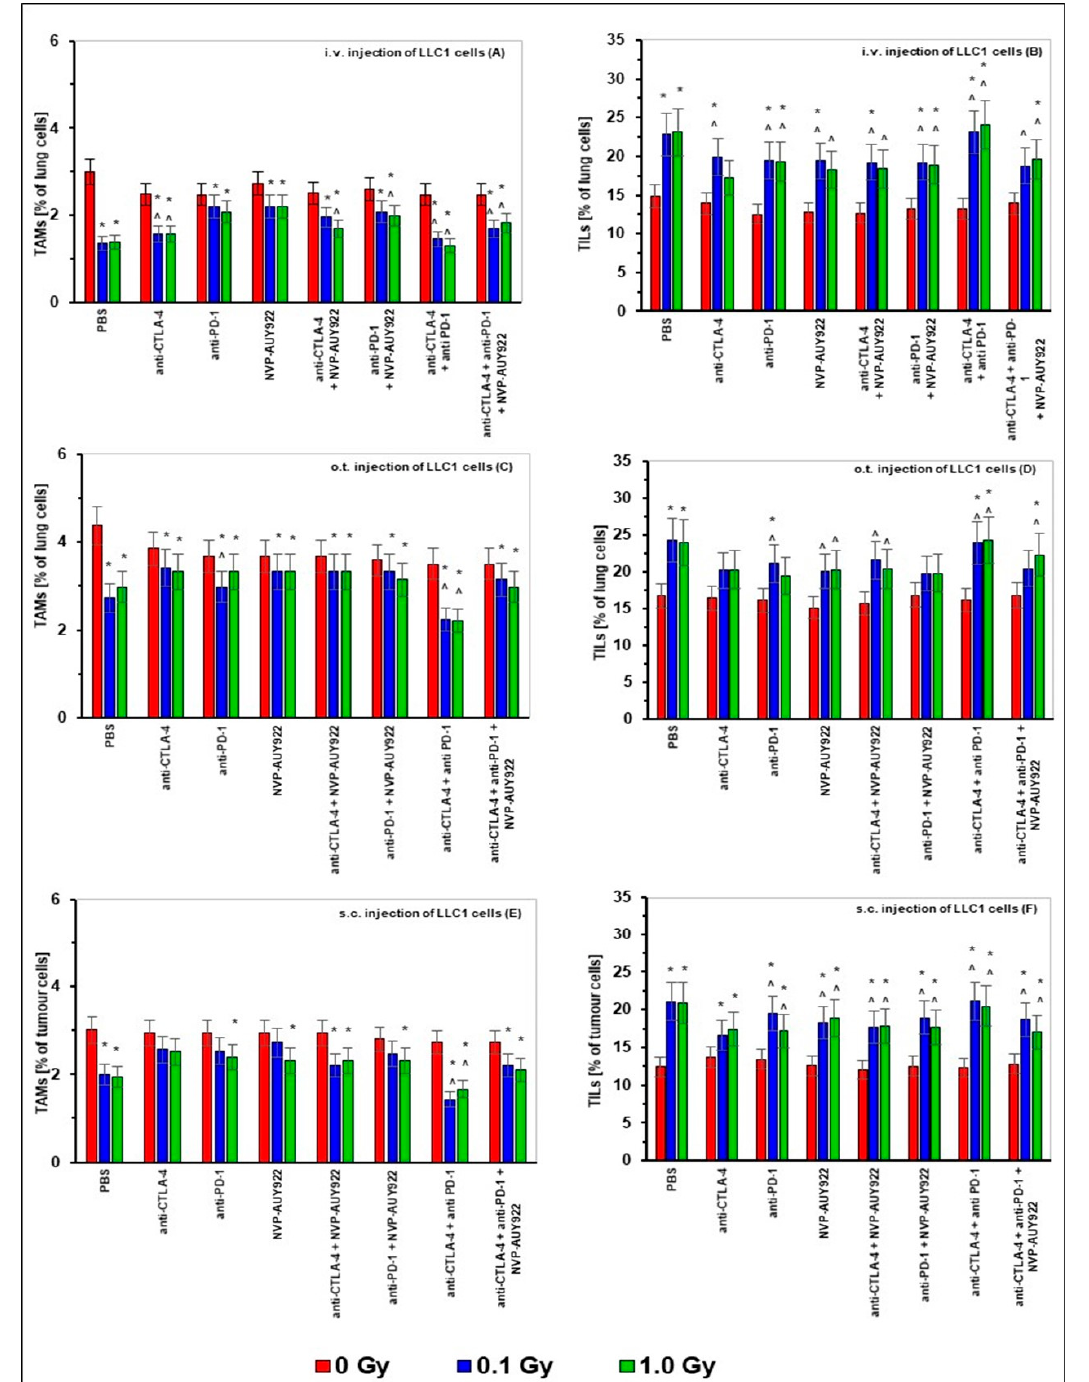
Figure 4. The percentages of tumour- associated macrophages (TAMs) (panels A , C , E ) and tumour-infiltrating lymphocytes (TILs) (panels B , D , F ) in the lungs after i.v. (panels A , B ) or o.t. (panels C , D ) injection with LLC1 cells or in tumors after s.c. (panels E , F ) injection of LLC1 cells to C57BL/6 mice treated with blockers of the immune checkpoints and/or HSP90 combined with WBI at total doses of 0.1 and 1.0 Gy. The bars indicate mean percentages of TAMs and TILs calculated for six (i.v. and o.t. injection of tumor cells) or three (s.c. injection of tumor cells) mice per group are presented. * indicates statistically significant ( p < 0.05) difference from the results obtained in the sham-exposed mice injected with PBS; ^ indicates statistically significant ( p < 0.05) difference from the results obtained in the sham-exposed mice injected with the same inhibitory molecule or a combination of these molecules.